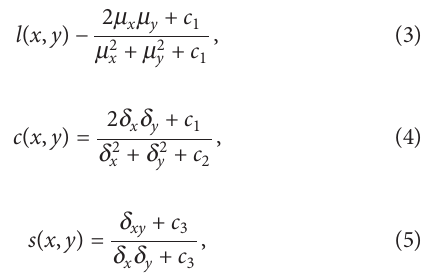
( Figure 3 ): type 1 classi fi ed errors into two classes based on whether the isocenter error was over 3 mm, and the isocenter